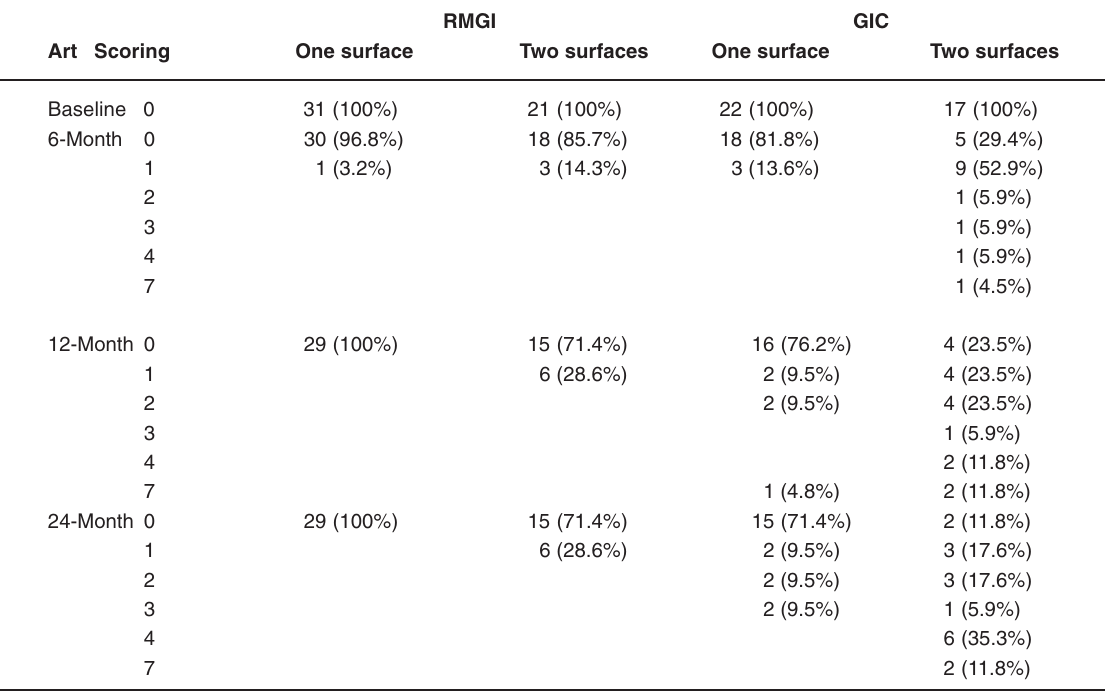
TABLE 1- ART scoring number and percent distribution of both RMGI and GIC-ART restorations at baseline (Scores 0 and 7 are successful) and comparison of two materials